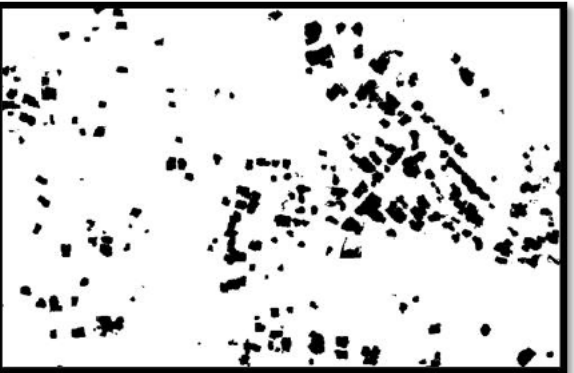
Figure 10. Haiti building detection